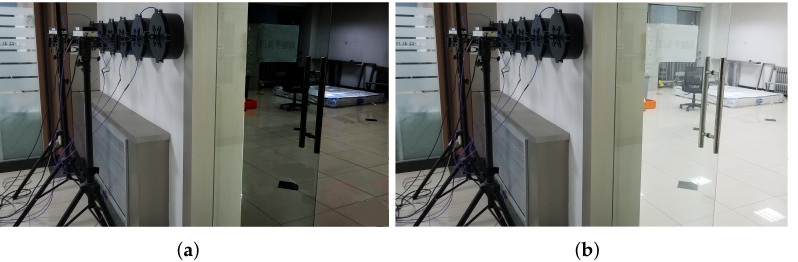
Figure 5. Through-the-wall human motion measurement scenario, ( a ) without live wire, and ( b ) with live